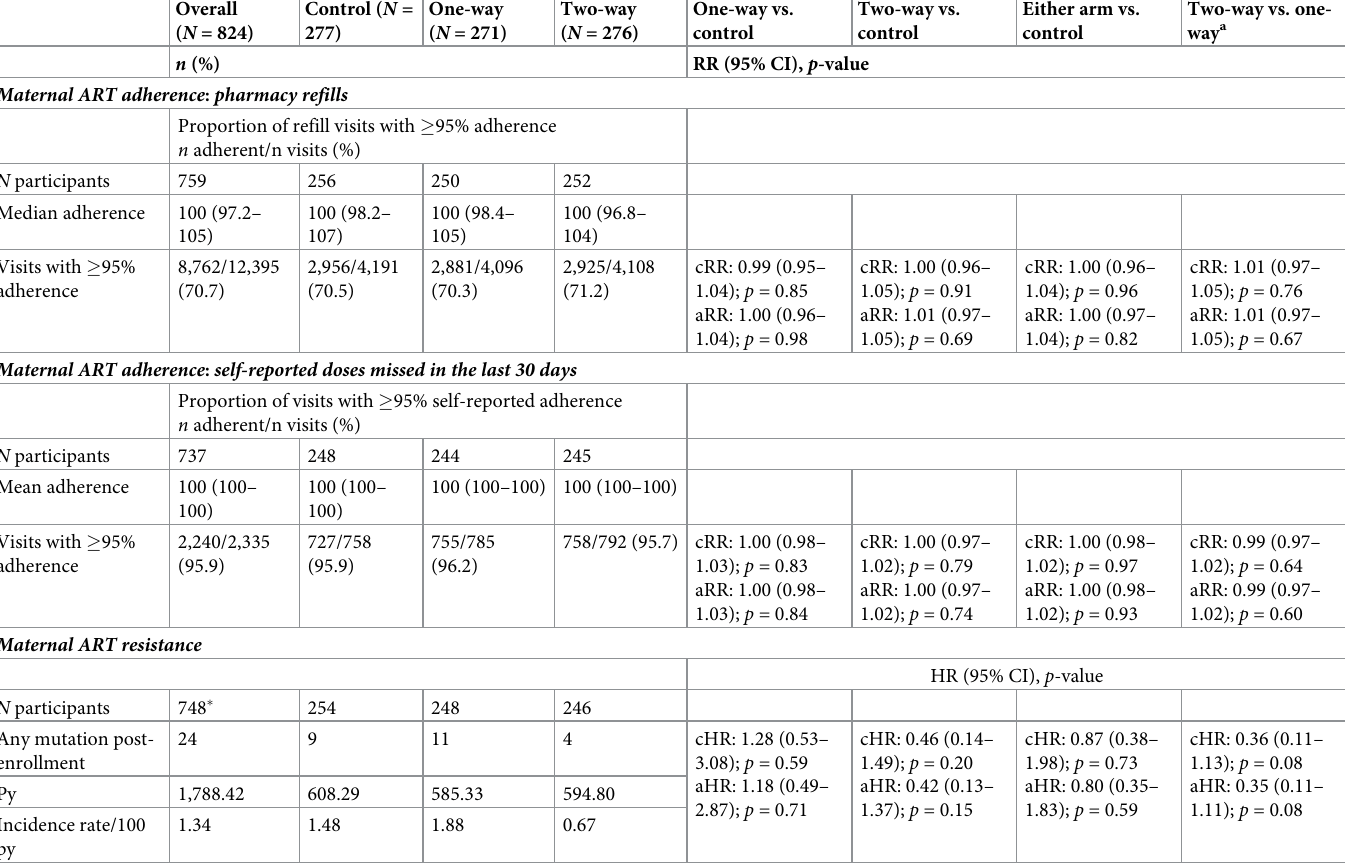
Table 3. Effect of Mobile WACh-X on secondary